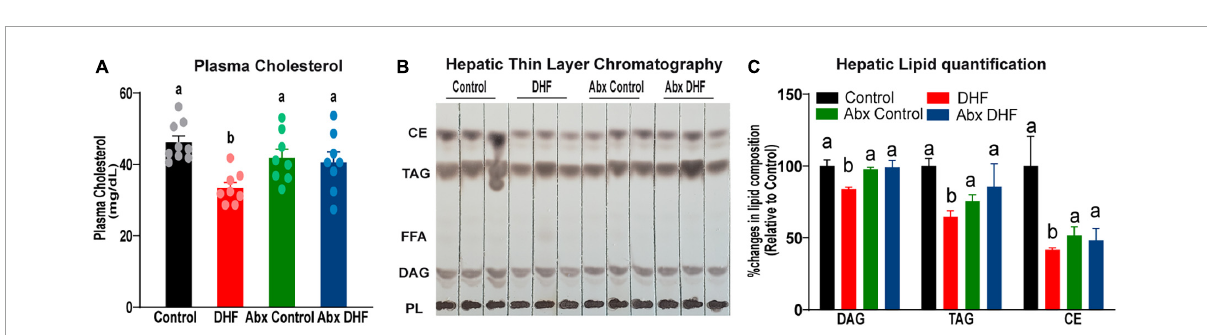
FIGURE2 Gut microbiome ablation prevents improvement in lipid metabolism by DHF. (A) Plasma free cholesterol was measured at the end of 12 weeks of HFD-feeding in conventional and microbiome-ablated groups. Data are expressed as average ± SEM ( n = 8–9). (B) Hepatic lipids were separated by thin layer chromatography (TLC). CE, cholesterol esters; DAG, diacylglycerols; FFA, free fatty acids; PL, phospholipids; TG, triglycerides. (C) Hepatic lipid quantification was done by ImageJ software. Data were analyzed by one-way ANOVA followed by Bonferroni post hoc comparison. p -values < 0.05 were considered significant. Groups with different letters are significantly different from each other. Data are expressed as average ± SEM ( n = 3).